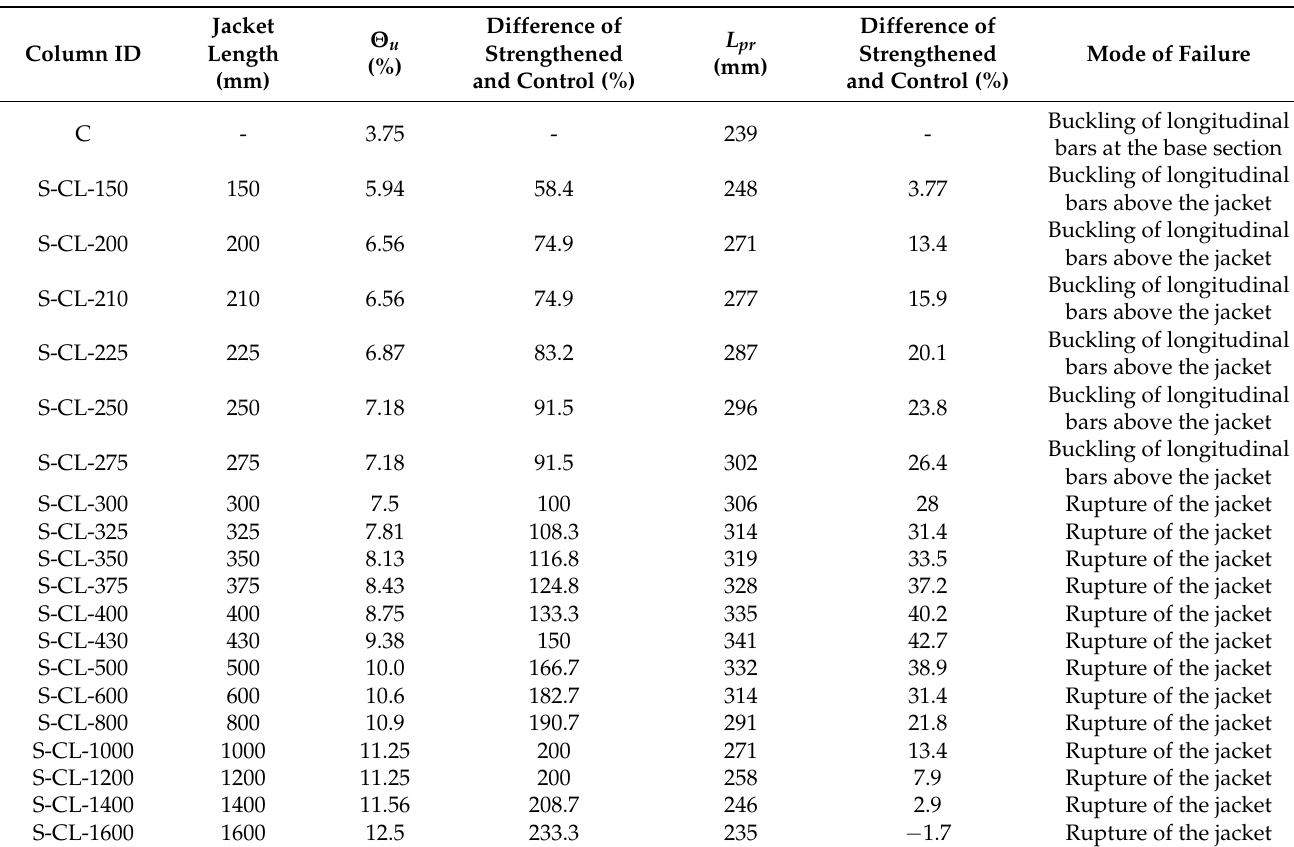
Table 3. Results of TRM Strengthened Column Models with Various Jacket